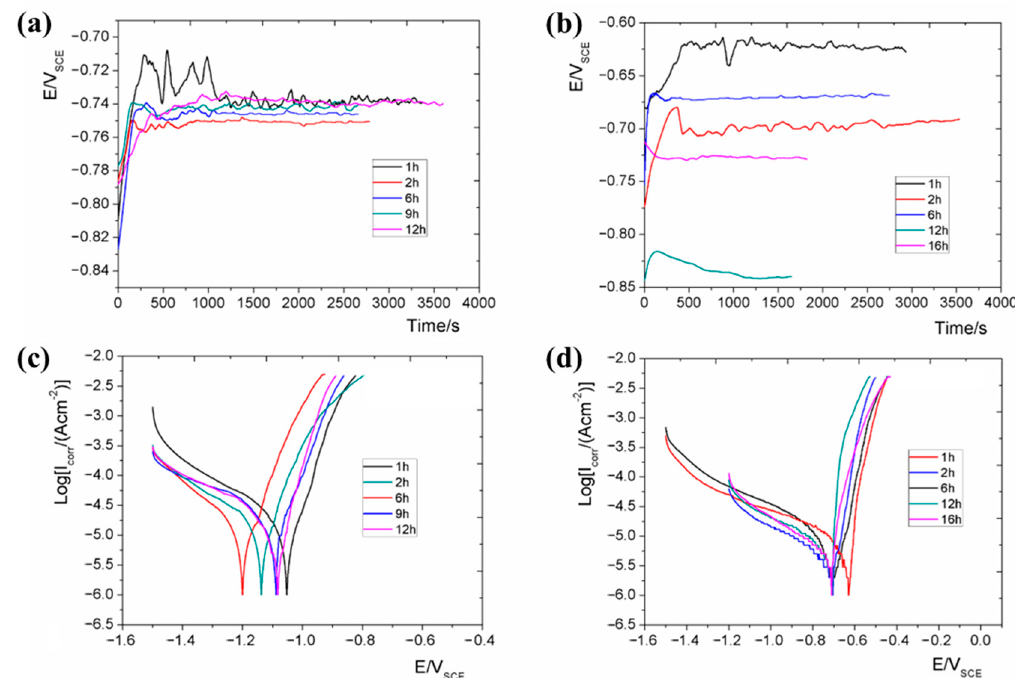
Figure 2. Open circuit potentials of ( a ) Al-7%Si-0.3%Mg-0.3%Cr alloy and ( b ) Al-7%Si-0.3%Mg- 0.3%Cr-1.5%Cu alloy and Tafel plots of ( c ) Al-7%Si-0.3%Mg-0.3%Cr alloy and ( d ) Al-7%Si-0.3%Mg- 0.3%Cr-1.5%Cu alloy in a 3.5% NaCl solution after di ff erent ageing time.